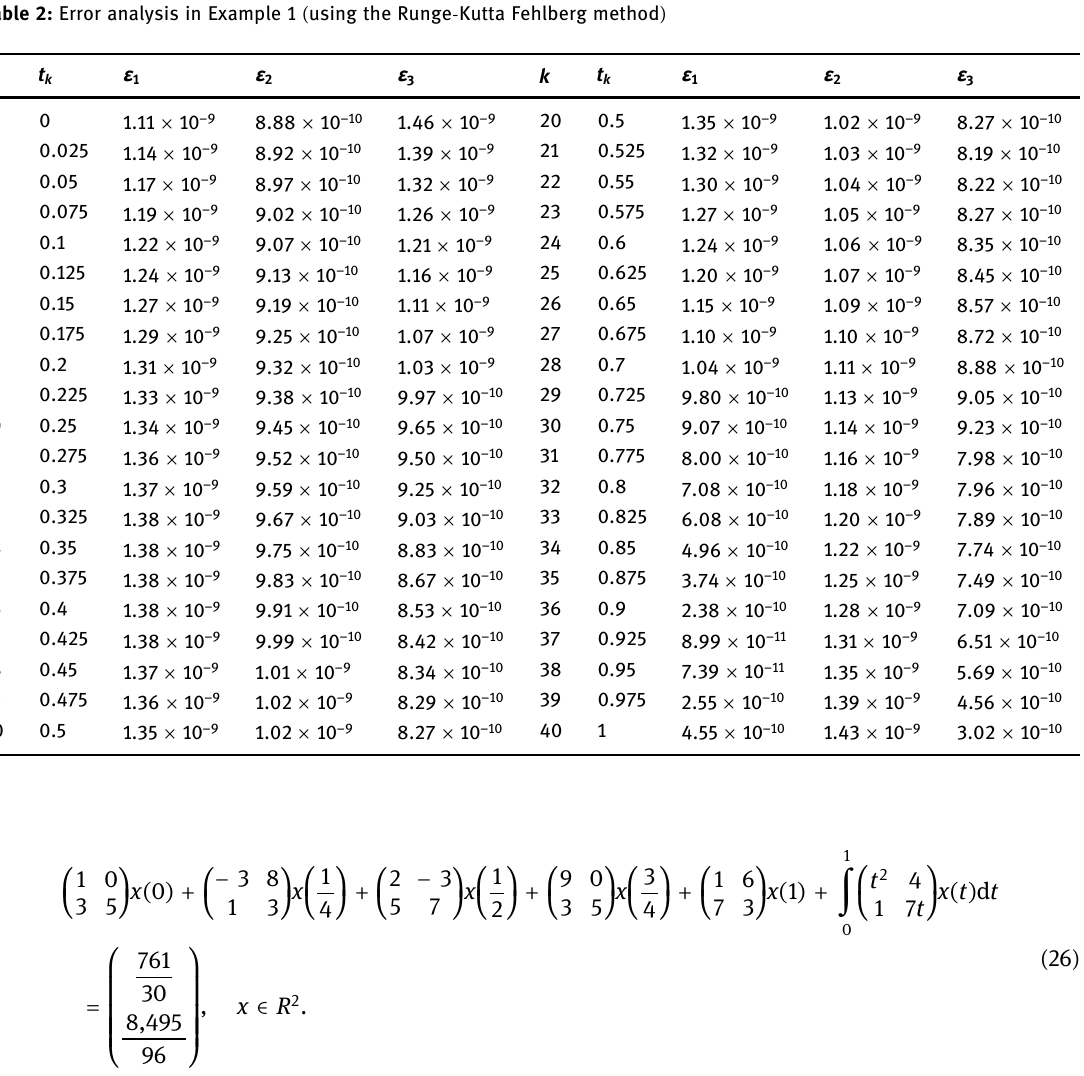
Table 2: Error analysis in Example 1 ( using the Runge - Kutta Fehlberg method